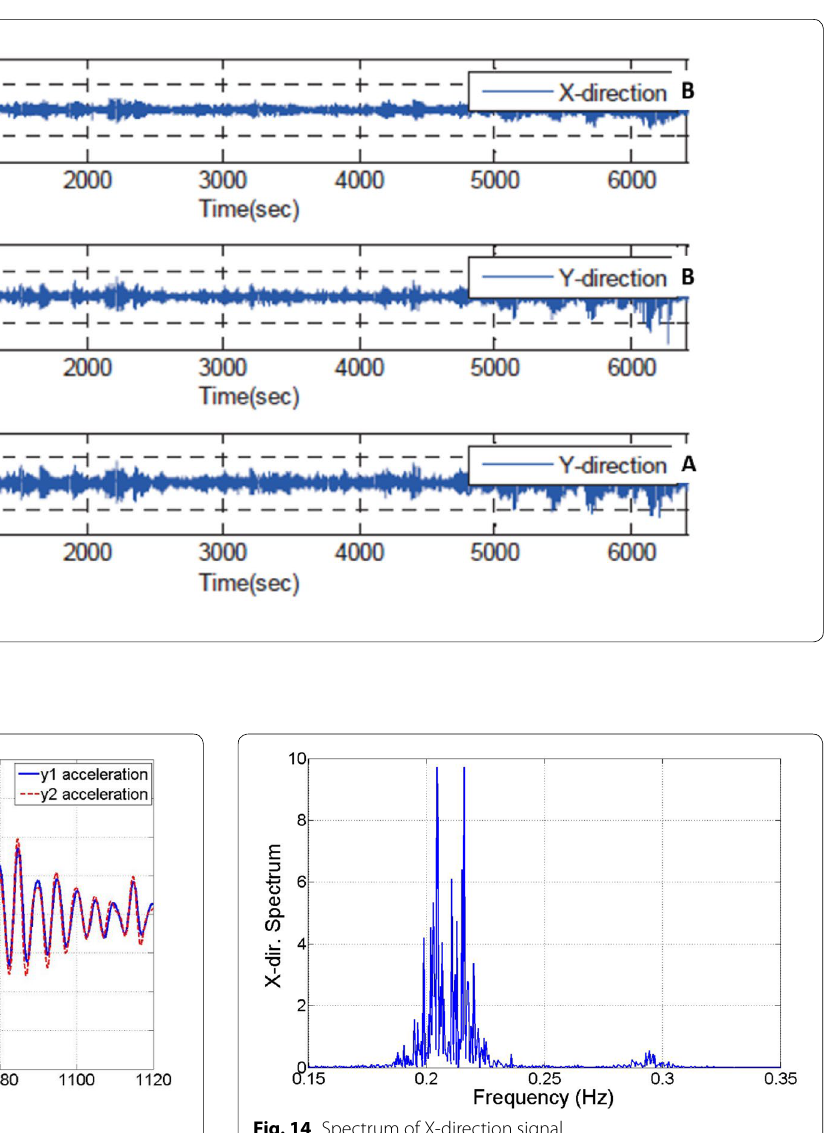
Fig. 14 Spectrum of X‑direction